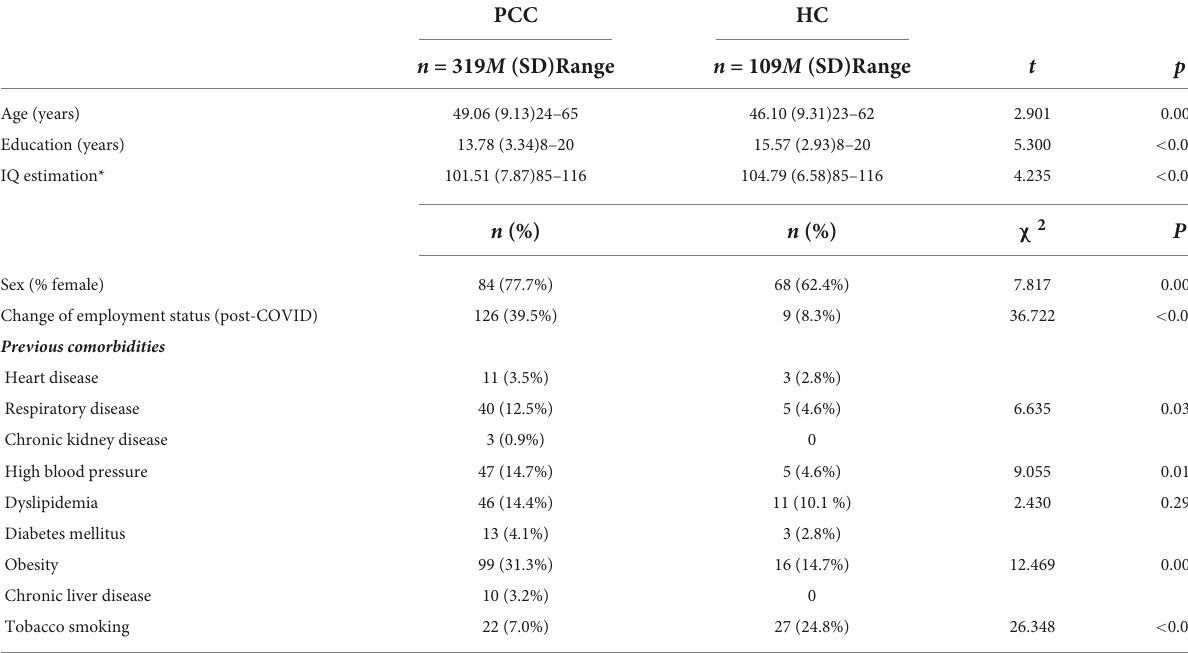
TABLE 1 Socio-demographic characteristics and comorbidities for the PCC and HC